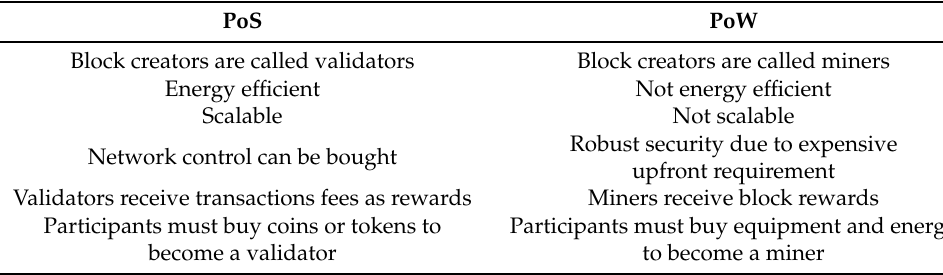
Table 1. Comparison between the PoS and